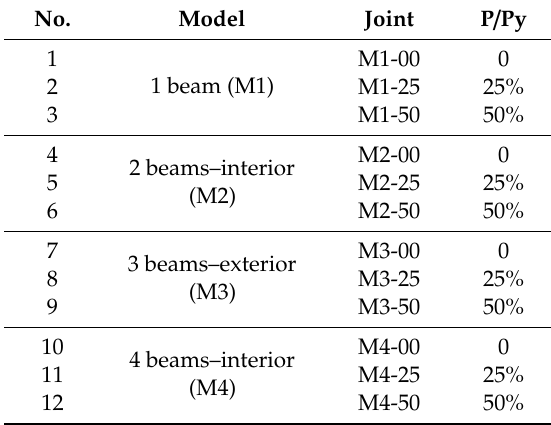
Figure 3. Interior ( M2,M4 ) and exterior ( M1,M3 ) joint configurations studied. Table 1. Configuration of beam-to-column joints in FE